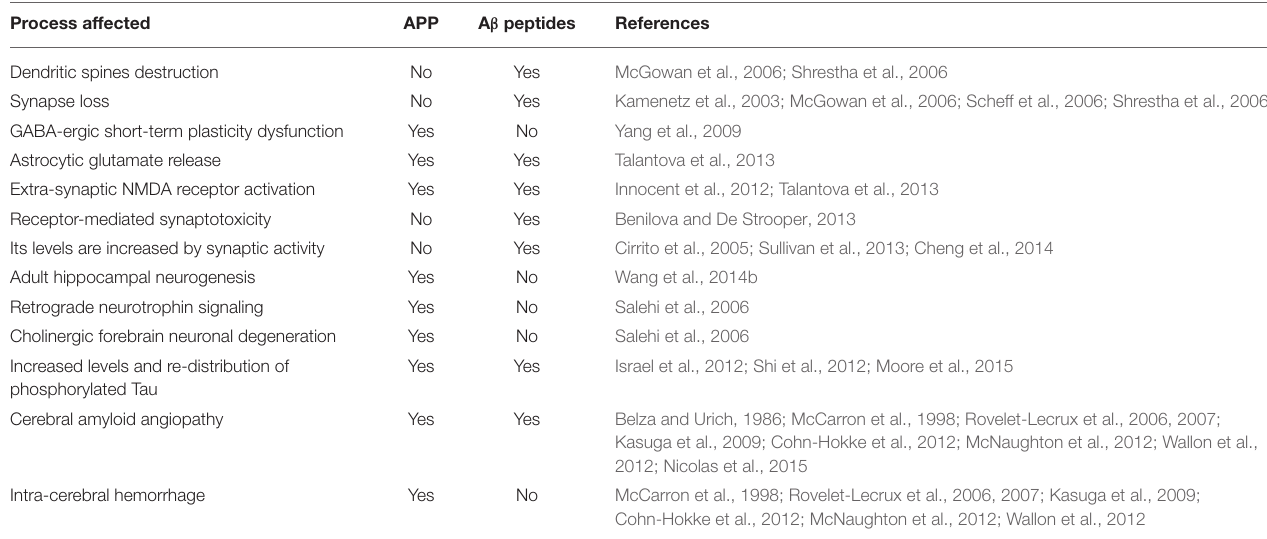
TABLE 2 | An overview of a variety of processes affected by an increased dose of APP protein and/or its derivative A β peptides, that may contribute in DS to pathogenesis of Alzheimer’s dementia or cognitive impairment (I.D.), or both. Process